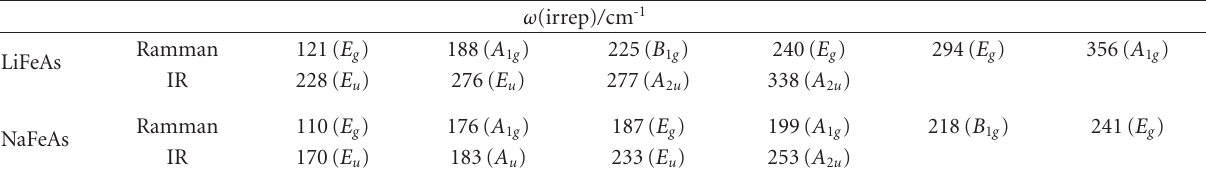
Table 1: The calculated frequencies, in cm − 1 , of the Raman- and infrared-(IR-) active modes in LiFeAs and NaFeAs. The modes are classified by the irreducible representations (irreps) according to which they